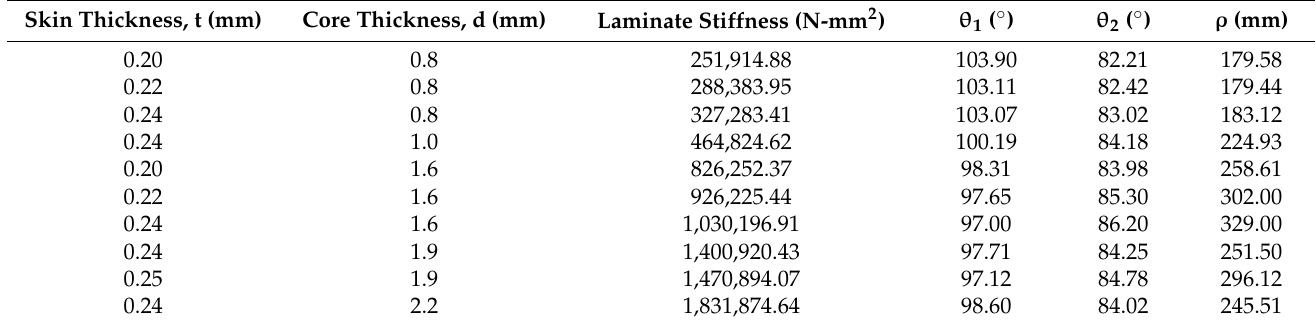
Table 5. Bending stiffness and springback of SA5182/Polypropylene/SA5182